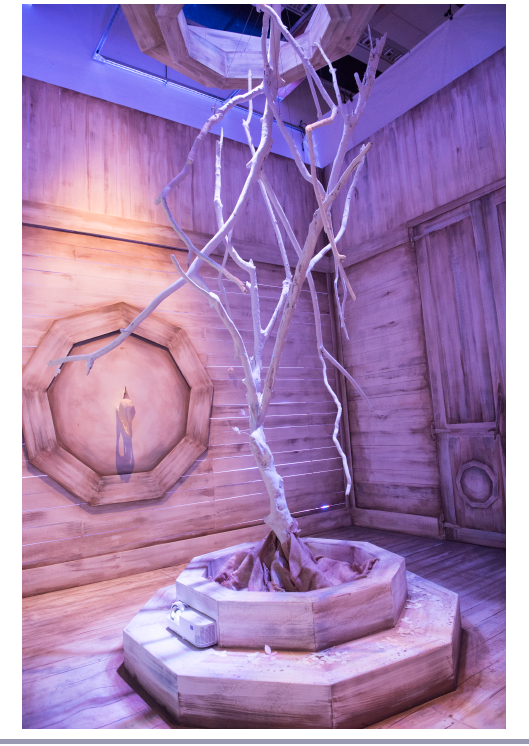
Fig. 4 . The spiritual room. (Photo by Emily